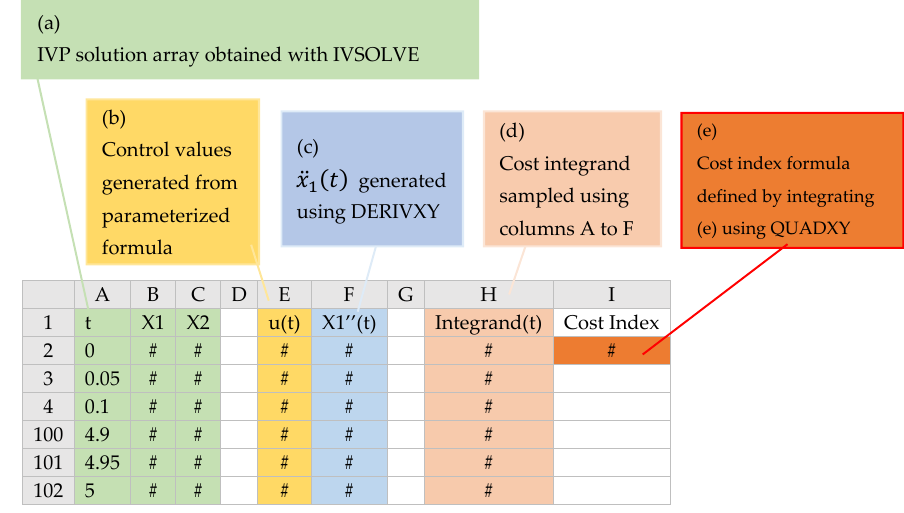
Figure 1. Illustration of the ordered steps to define an analog formula for the cost index (1) which encapsulates the inner IVP (2)–(3).